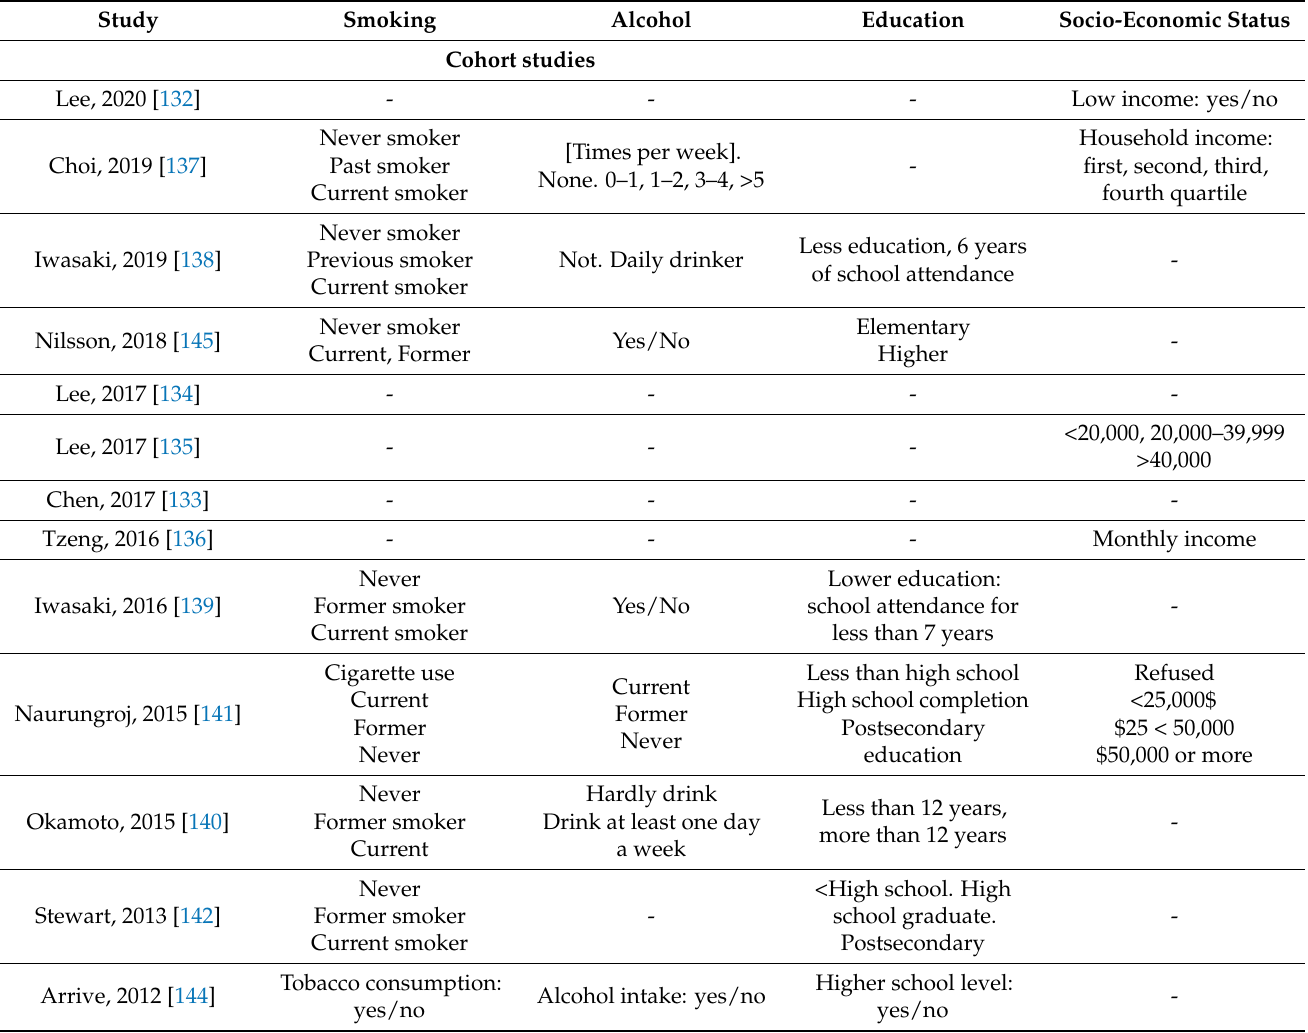
Table 8. Potential, co-existing residual confounders in 17 included